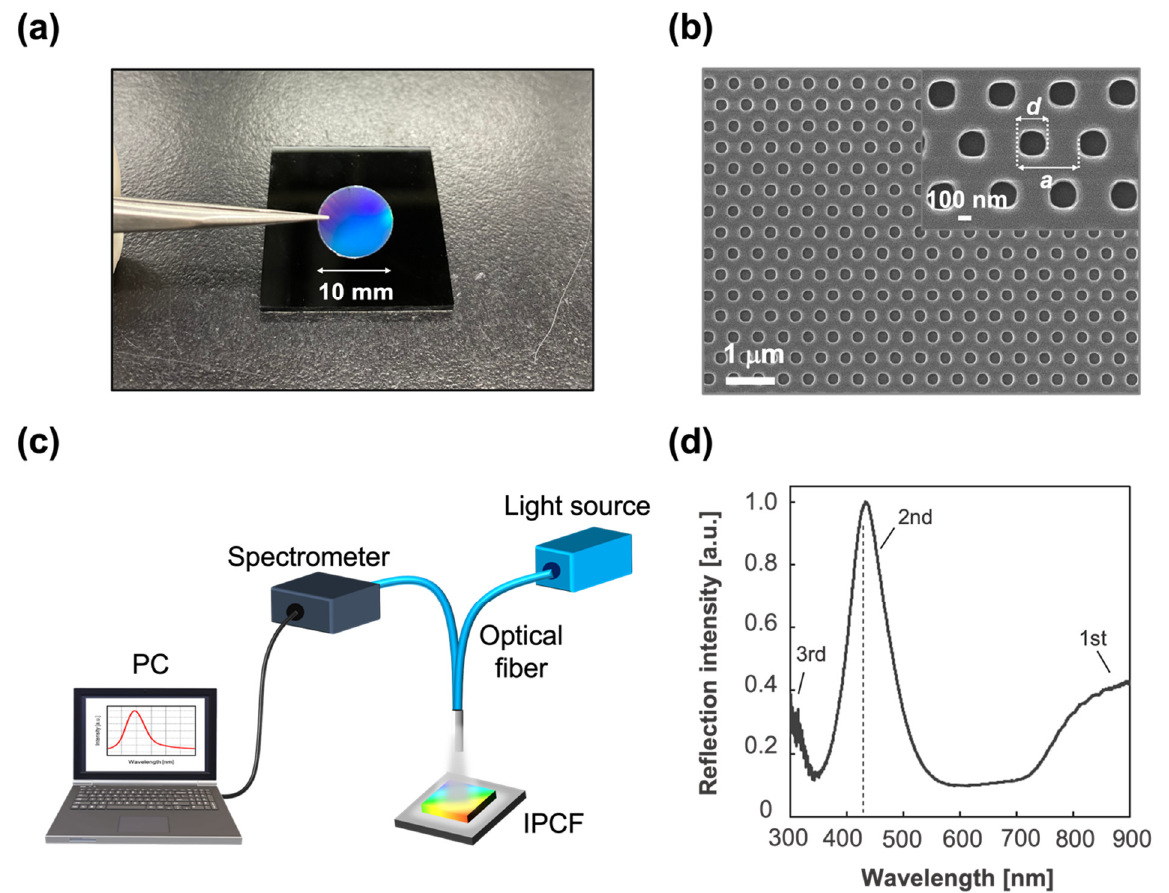
Figure 2. IPCF for label-free optical sensor. ( a ) Image of an IPCF chip. The diameter of the chip used for the sensor was 10 mm. ( b ) SEM image of the IPCF surface. The inset image shows that the diameter of the holes ( d ) was 230 nm and the lattice constant ( a ) was 460 nm. ( c ) Schematic illustration of the optical setup for reflectometry with the IPCF. It was composed of a tungsten-halogen lamp as a light source, an optical fiber probe, and a spectrometer. ( d ) Typical reflection spectrum of the IPCF. The diffraction was attributed to Bragg’s law, 2 a sin θ = m λ ; the observed peaks were distributed to the 1st, 2nd, and 3rd Bragg peaks ( m = 1, 2, and 3).